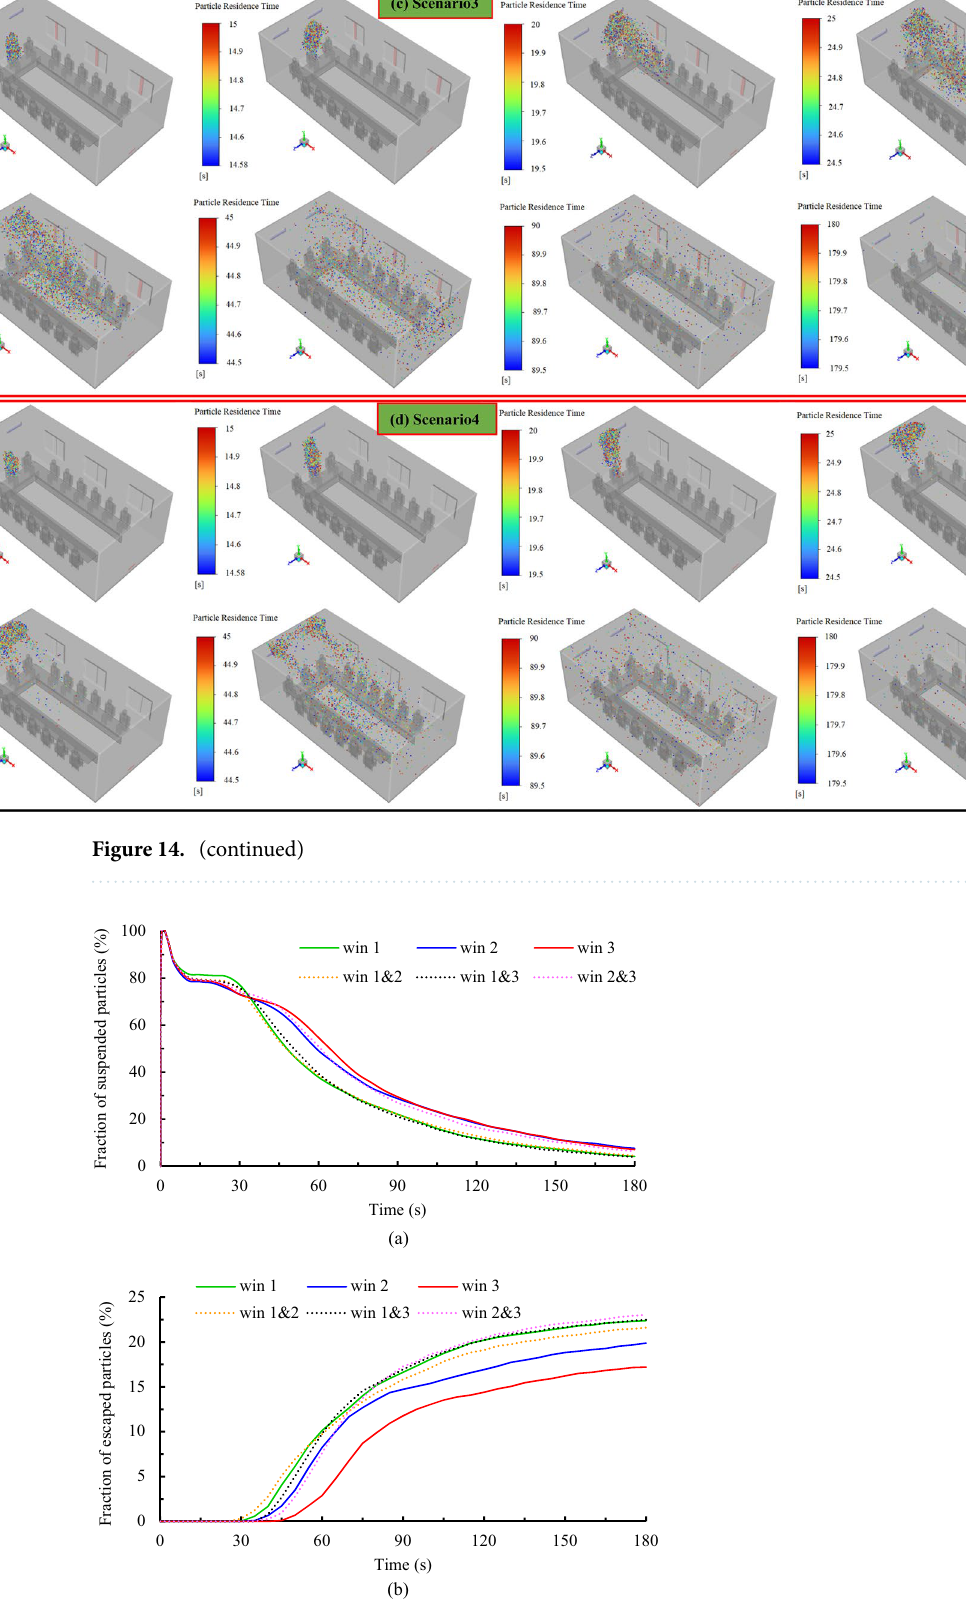
Figure 15. Effects of the exhaust layouts on the dispersion of the particles during scenarios 5 through 10; ( a ) variation of the suspended particles versus time and ( b ) variation of the escaped particles versus